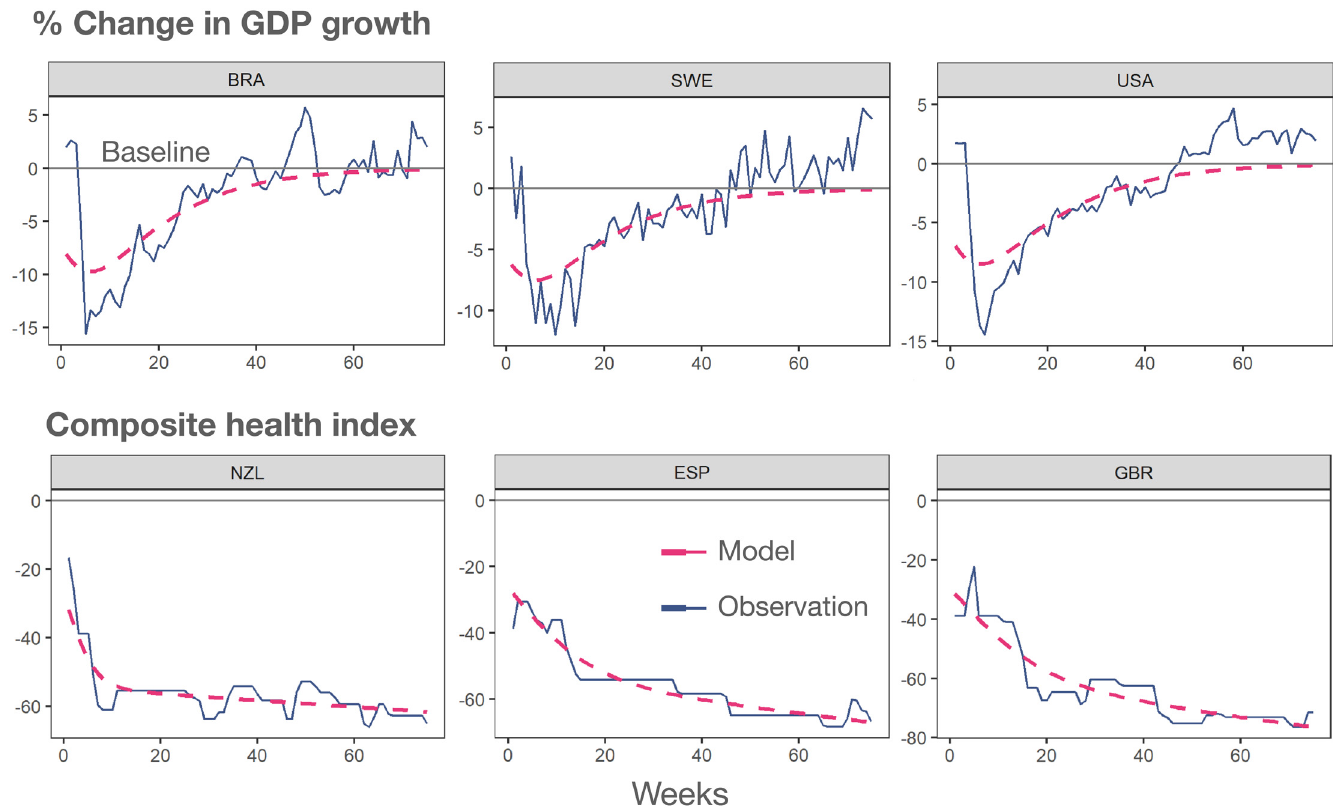
Fig 2. Agreement between model and country-level change indices. Observed time course of two distinct indices, economic (top) and health (bottom), for six distinct countries worldwide. The dashed line indicates the fit obtained through the corresponding shock function introduced in this